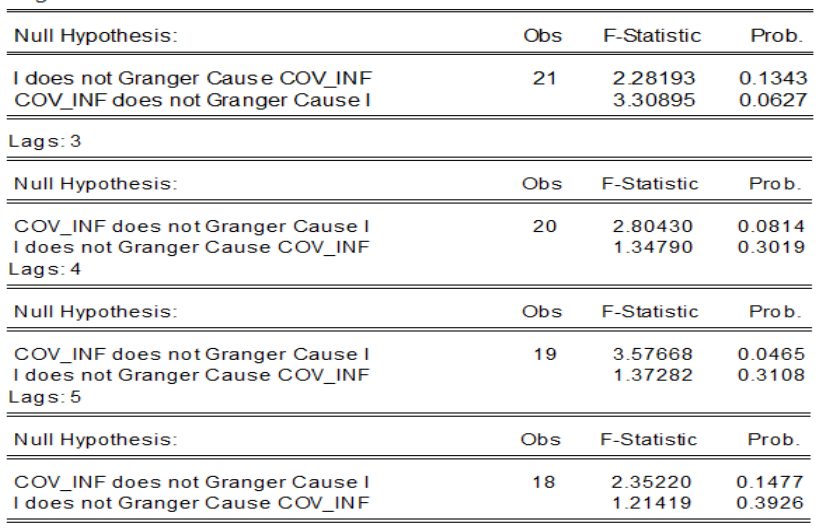
Figure 3. Results of the Granger test for the pair of variables “Number of infected persons with Covid- 19 - Import of goods”